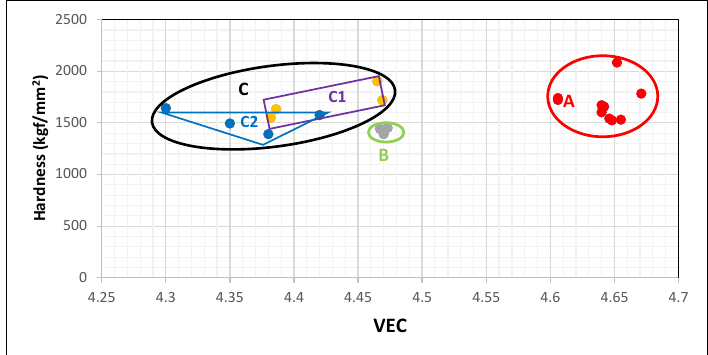
Figure 4. Vickers hardness of tetragonal Nb 5 Si 3 versus silicide parameter VEC in alloyed Nb 5 Si 3 with Ge but with no B, Sn, Mo, Ta or W. The data is represented by filled circles. The data shown in red colour is for Nb 5 (Si,Ge) 3 , (Nb,Cr) 5 (Si,Ge) 3 , Nb 5 (Si,Ge,Al) 3 , the data shown in green colour is for (Nb,Ti) 5 (Si,Ge) 3 , the data shown in purple colour is for Nb 5 Si 3 alloyed with Ge and with Ti + Cr (i.e., (Nb,Ti,Cr) 5 (Si,Ge) 3 ) or with Ti + Al and the data shown in blue colour is for Nb 5 Si 3 alloyed with Ge and with Ti + Al + Cr or with Ti + Hf + Al + Cr. For areas A, B, C, the rectangle C1 and the triangle C2 see text.